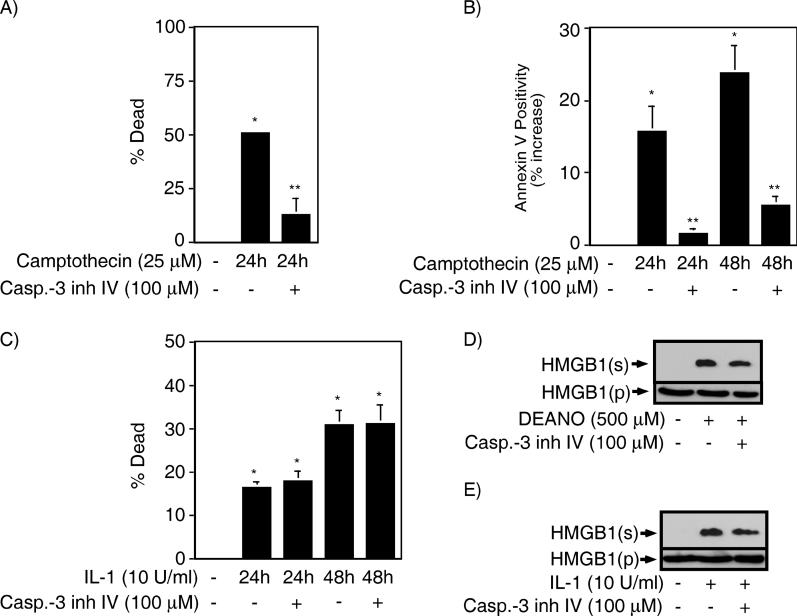
Caspase-3 Inhibition Prevents β-Cell Apoptosis but Does Not Prevent IL-1-Induced NecrosisThe caspase-3 inhibitor Z-DQMD-CHO (100 μM) attenuated RINm5F cell death induced by a 24-h incubation with camptothecin as determined by MTT assay (A) or annexin V staining (B). This caspase-3 inhibitor failed to prevent RINm5F cell death in response to a 48-h incubation with 10 units/ml IL-1 as determined by the MTT assay (C). Z-DQMD-CHO also did not attenuate HMGB1 release by RINm5F cells treated for 24 h with 500 μM DEANO (D) or for 48 h with 10 units/ml IL-1 (E). The levels of HMGB1 released into the supernatant (s) and contained in the cells (p) were determined by Western blot analysis. Results for MTT assay (A and B) and annexin V staining (C) are the average ± SEM of three independent experiments. *p < 0.05, significantly different from untreated control. **p < 0.05, significantly different from camptothecin-treated condition. Results for HMGB1 release are representative of three independent experiments.